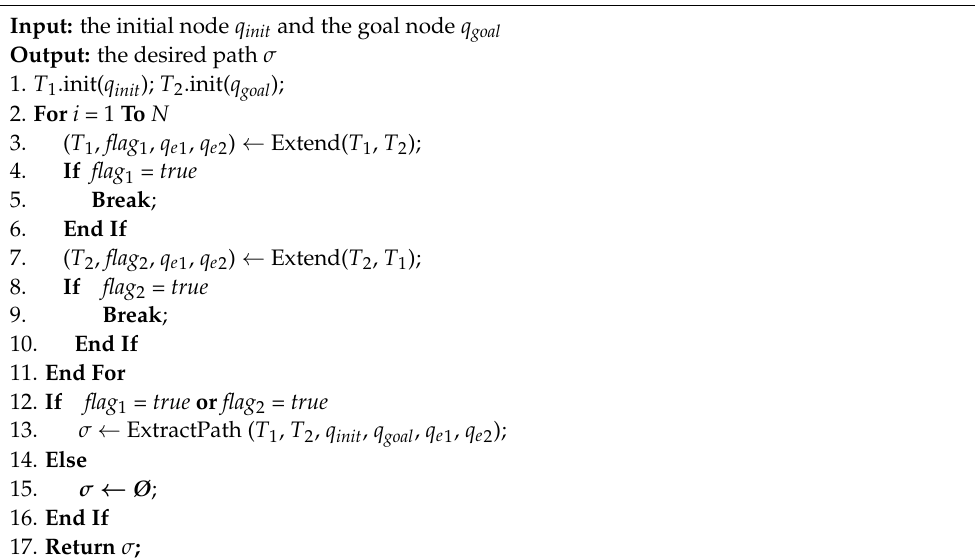
Algorithm 1. Bidirectional